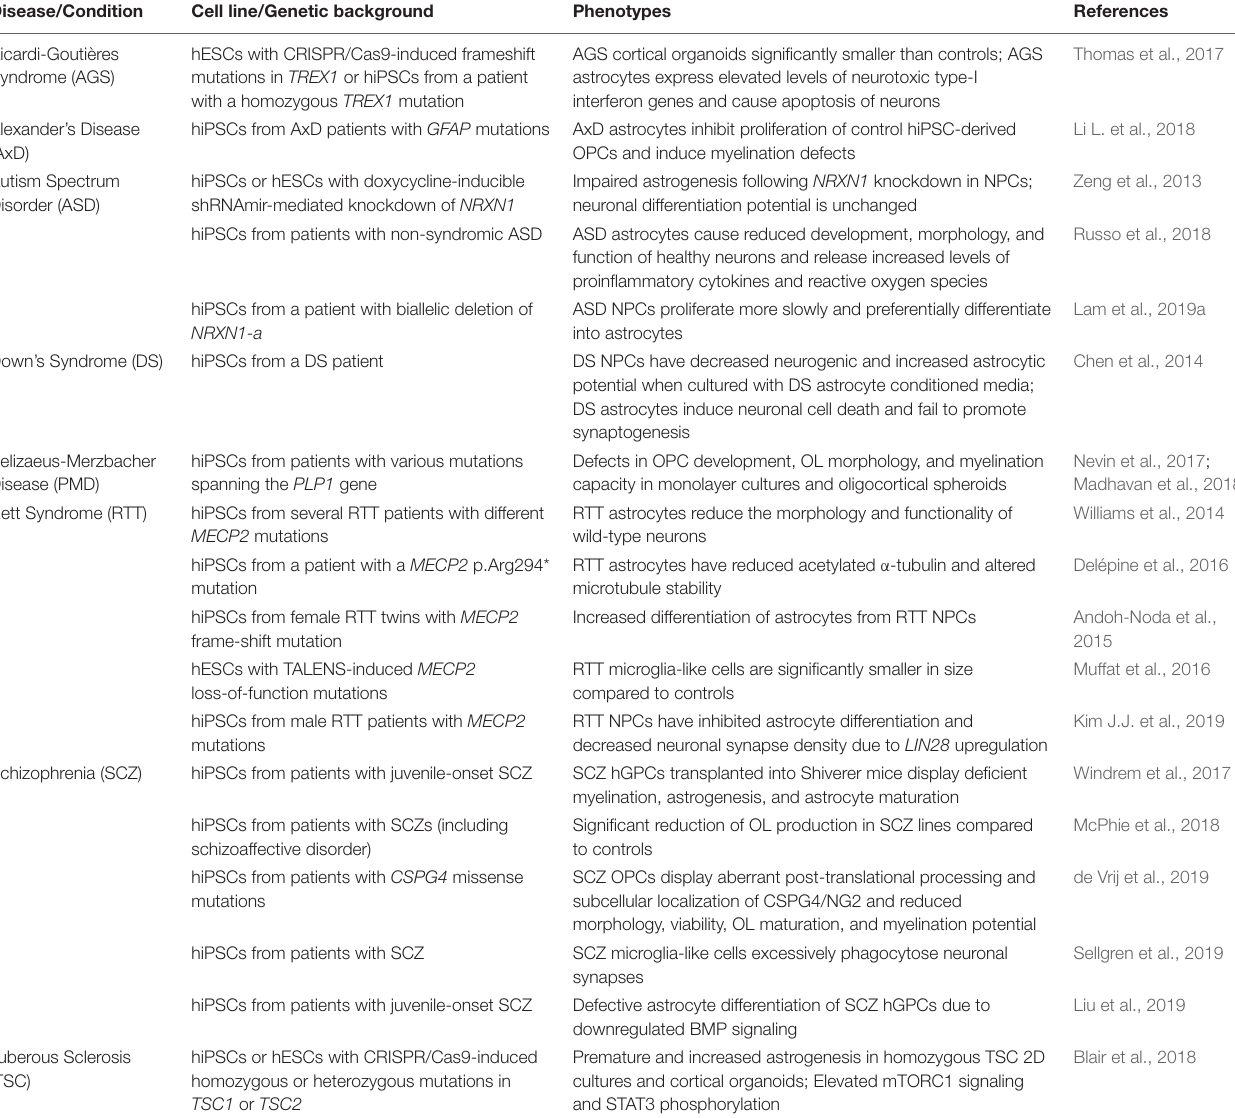
TABLE 1 | Using human stem cell models to determine glial contributions to neurodevelopmental